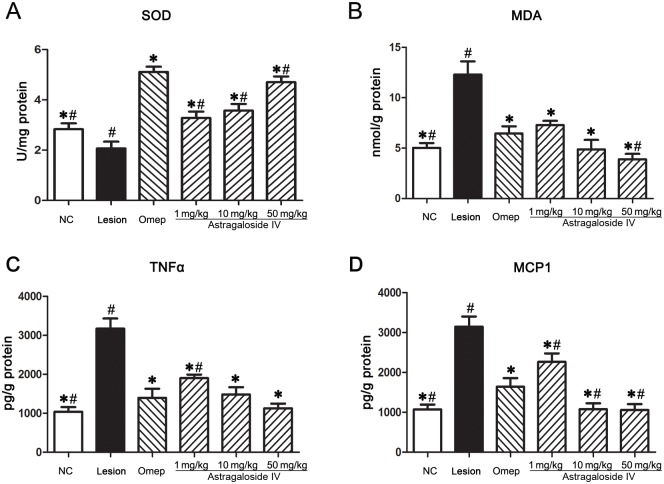
The effects of astragaloside IV on the SOD, MDA, TNFα and MCP1 response level in gastric homogenate.The SOD, MDA, TNFα and MCP1 response level were quantified using ELISA. All results expressed as mean ± standard error of mean. *Significant difference (P< 0.05) when compared with the lesion control (group 2). #Significant difference (P< 0.05) when compared with the omeprazole (group 3).